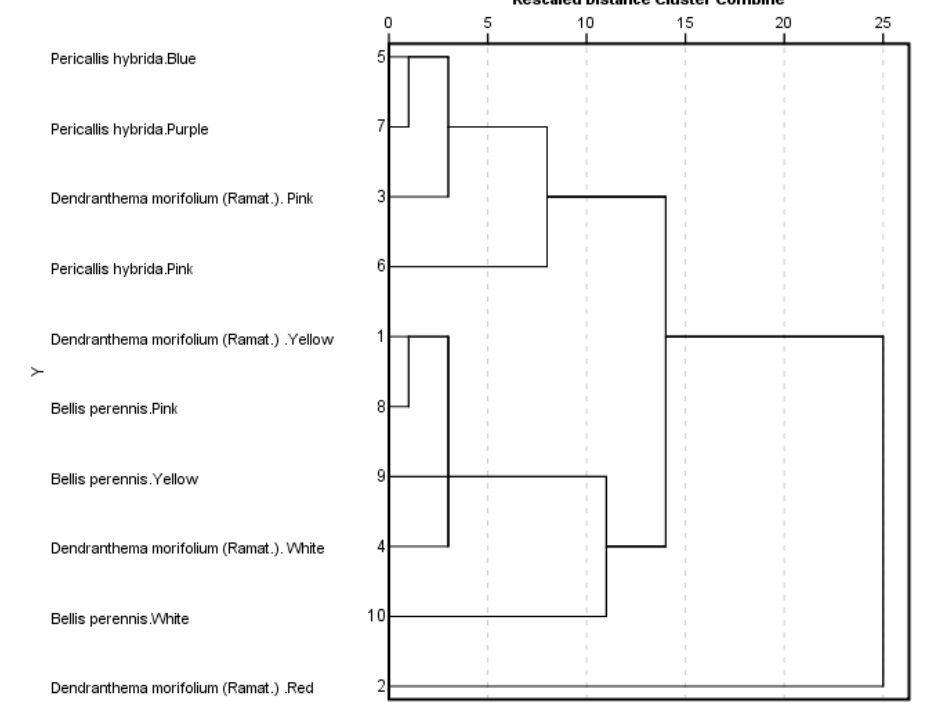
Figure 5. Dendrogram from volatile components of 10 taxa of Chrysanthemum morifolium based on Ward’s minimum variance clustering method.